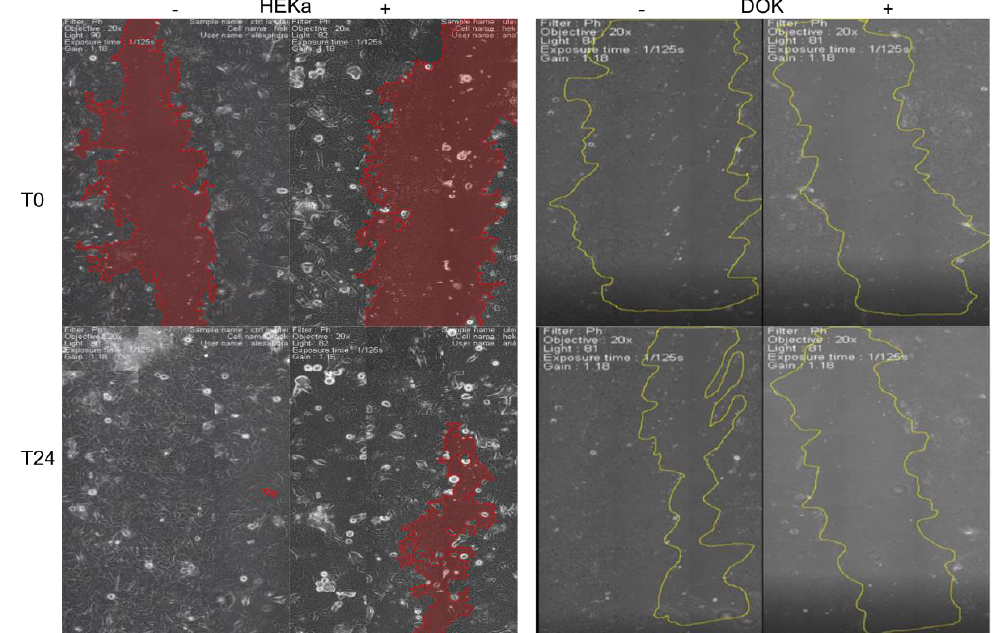
Figure 3. Real-time assessment of cell migration and proliferation of normal and dysplastic keratinocytes, treated (+) with sea-buckthorn seed oil. Treated cells (both normal and dysplastic) were less efficient in covering the denudated area. The effect was more prominent for dysplastic cells.